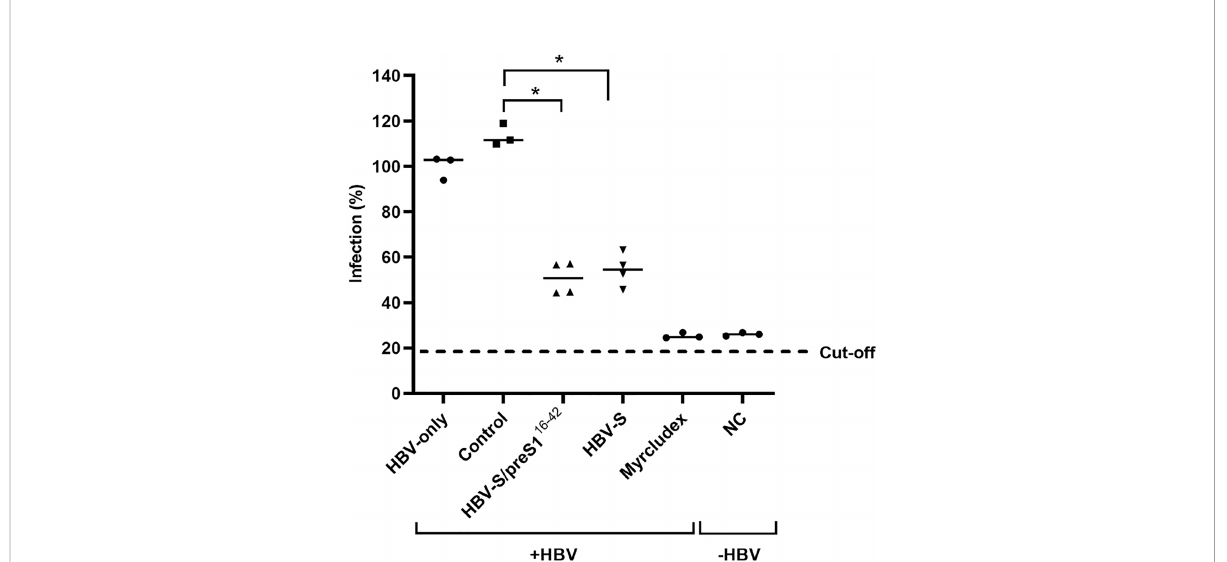
FIGURE 8 Neutralization of WT HBV infection by S and S/preS1 16-42 antisera. Pooled pre-immune sera or sera from mice immunized with S, S/preS1 16-42 , or background proteins (control) were diluted 1:50 and pre-incubated with HBV inoculum (100 Geq/cell), in medium supplemented with 4% PEG, for 1 h. HepG2 hNTCP cells were incubated with the sera-treated HBV inoculum for 16 h, or maintained non-infected, as negative control (NC). Cells incubated with Myrcludex B for 3 h prior to infection were used as a control for the speci fi city of inhibition of HBV infection. At 16 h post-infection the medium was supplemented with 2.5% DMSO and then changed every two days. Cell media were collected at day 11 post- infection and used to quantify the HBeAg levels by ELISA. Data are shown as percentage of HBV infection in the presence of post-immune sera from infection values obtained in the presence of the pre-immune sera, at the same dilution (n=4). Values in the presence of Myrcludex B and in the negative-control represent percentages of infection from HBV-only samples (n=4). Statistical analysis was performed by using the Mann- Whitney U test. Comparisons between control and HBV-S/preS1 16-42 or S groups are shown (*, p <